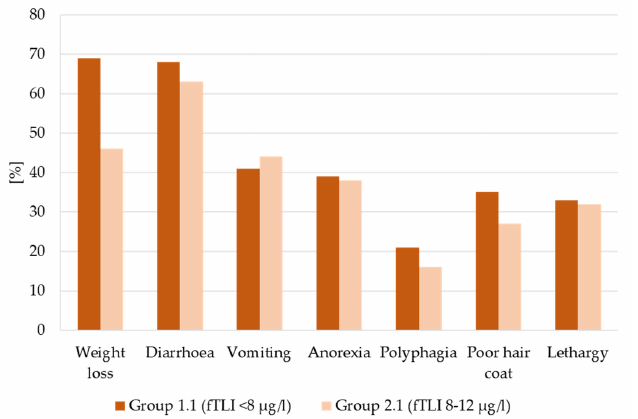
Figure 4. Percentage of occurrence of clinical signs in cats with decreased serum fTLI concentrations (group 1.1) and serum fTLI concentrations in the lower reference interval (group 2.1). Weight loss (group 1.1: 69%, group 2.1: 46%) and diarrhoea (group 1.1: 68%, group 2.1: 63%) were most reported in both groups, but cats with decreased serum fTLI concentration displayed more frequent weight loss. Other clinical signs were vomiting, anorexia, polyphagia, poor hair coat, and lethargy.